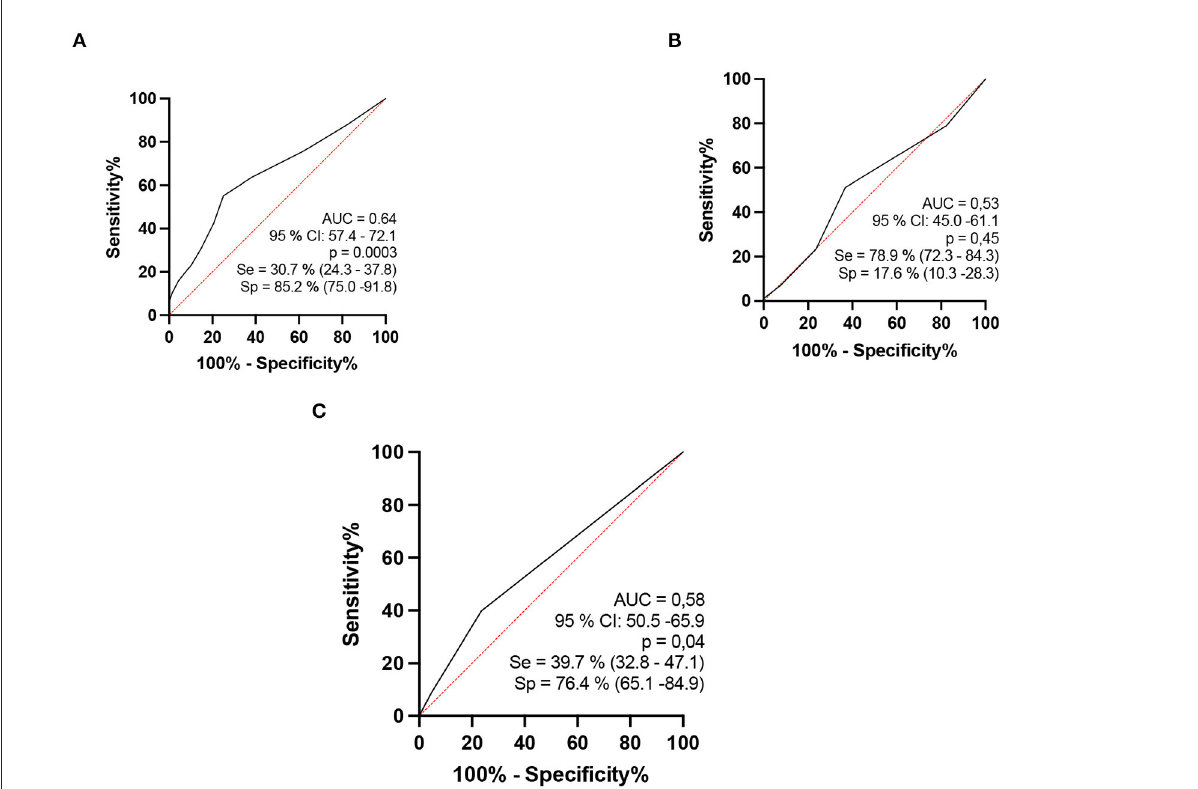
FIGURE7 Analysis by the ROC curve comparing HHC and patients with HD aged 15–60 years: percentage indices of altered nerves among the nerves evaluated per individual [ (A) up on the right]. The percentage indices of the number of asymmetries ( 1 CSA) [ (B) up on the left]. The percentage indices of the number of focalities ( 1 TpT) [ (C) as mentioned